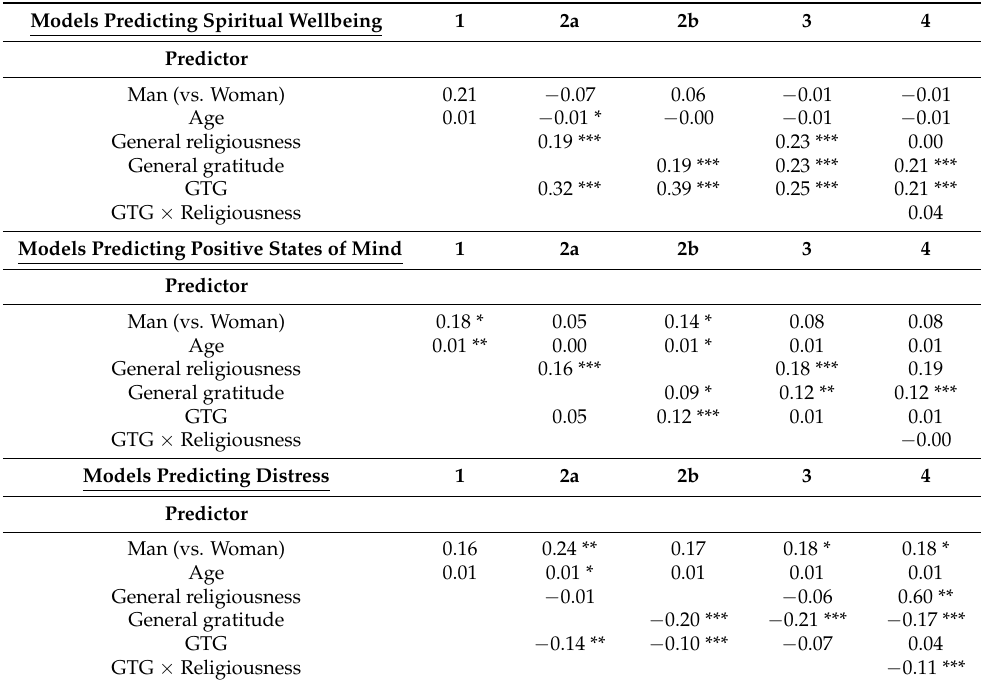
Table 3. Results from Regressions Predicting Spiritual Wellbeing, Positive States of Mind, and Psychological